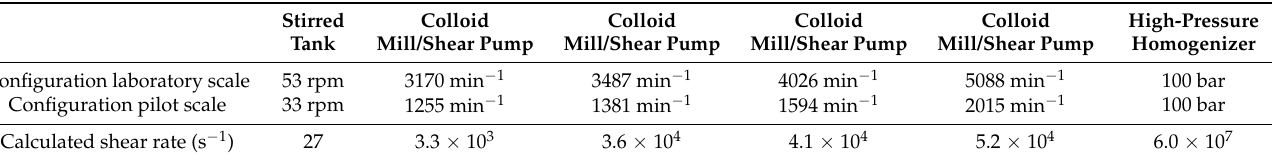
Table 2. Configurations chosen for shear treatments in laboratory and pilot scale for the same shear rate calculated with Equations